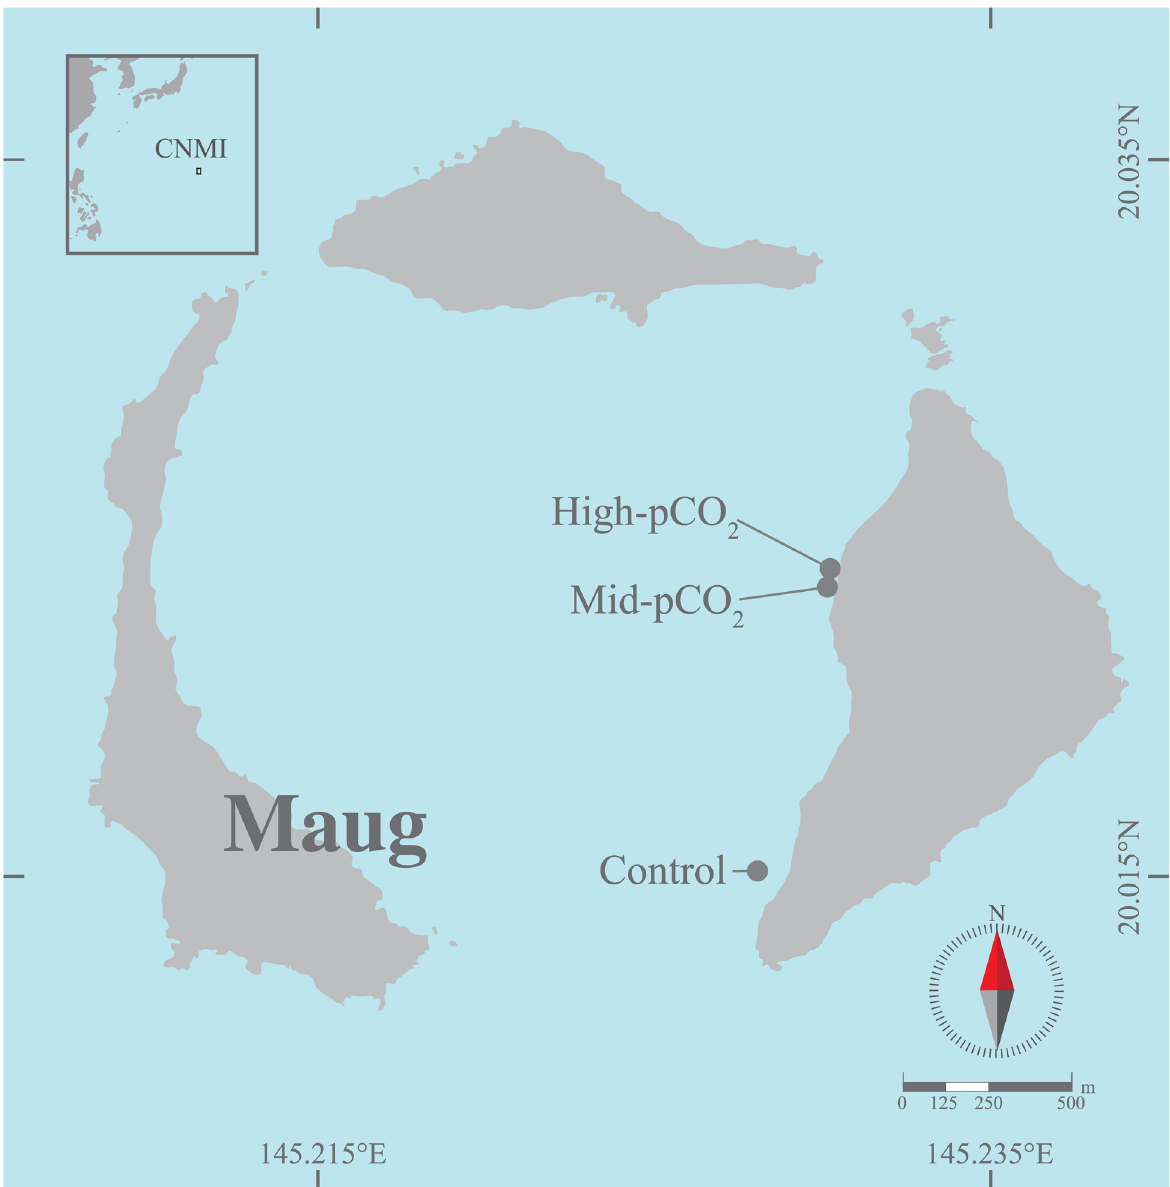
Fig 1. Map of Maug showing the locations of the High-pCO 2 , Mid-pCO 2 and Control sites. CNMI, Commonwealth of the Northern Mariana